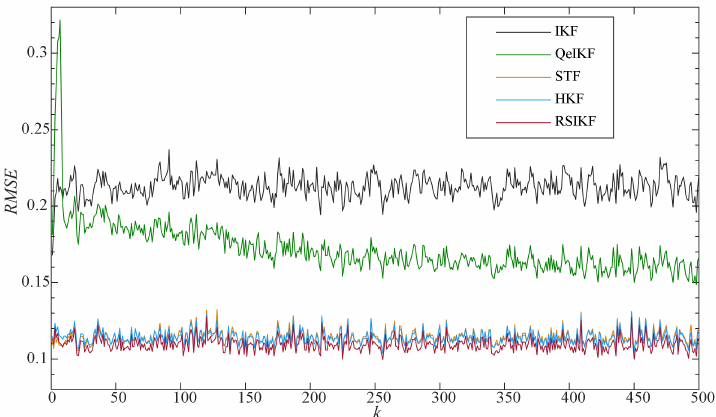
Figure 10. The RMSE k result of different methods for the case of α = 5 and β = 100.